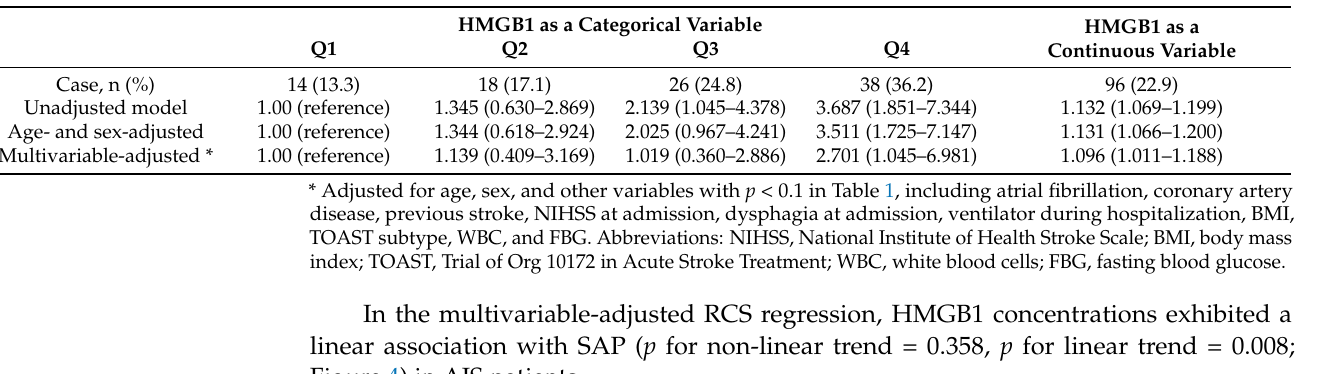
Table 2. Odds ratio and 95% confidence interval of SAP according to HMGB1 among acute ischemic stroke patients.